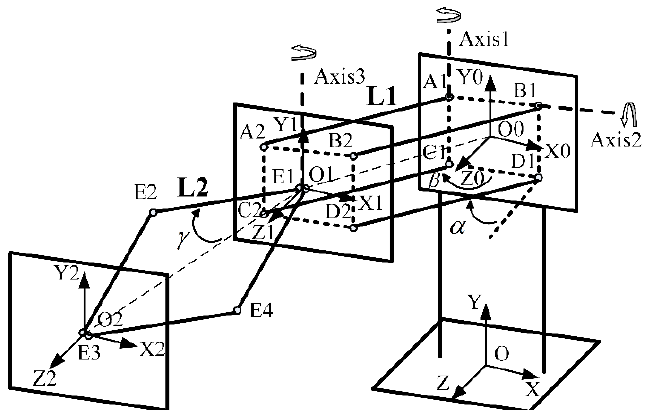
Figure 7. Motion measurement model of translational structure.